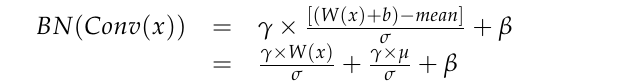
Figure 4. The process of structural re-parameterization of RepVGG block A and RepVGG block B. Substituting Equation (1) into Equation (2), we have: